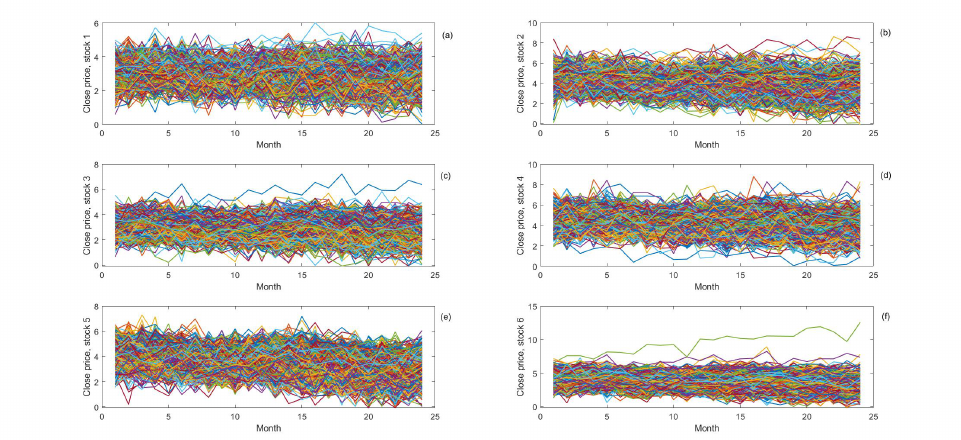
Figure 8. Random samples generated and their time-series prediction results for ( a ) Stock 1; ( b ) Stock 2; ( c ) Stock 3; ( d ) Stock 4; ( e ) Stock 5; ( f ) Stock 6.